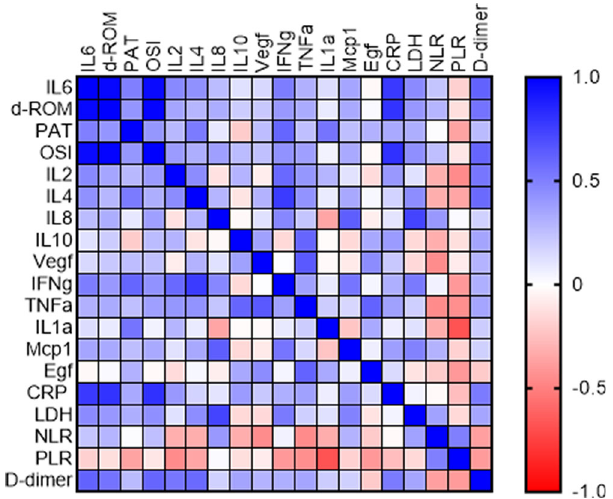
Figure 2. Spearman r presented as a heatmap between the investigated cytokines, oxidative stress param- eters, and commonly used biomarkers in